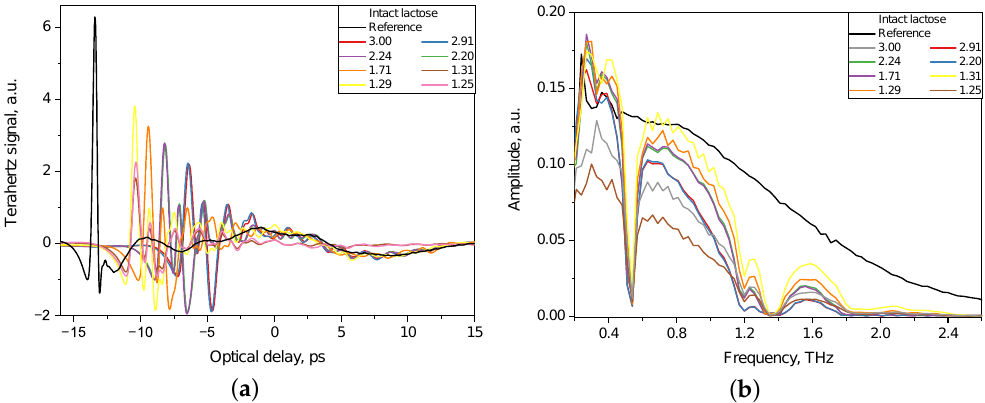
Figure 1. Reference signal and signal of tablets with various thickness (1.25–3.00 mm) obtained by THz-TDS system in time domain ( a ) and in frequency domain ( b